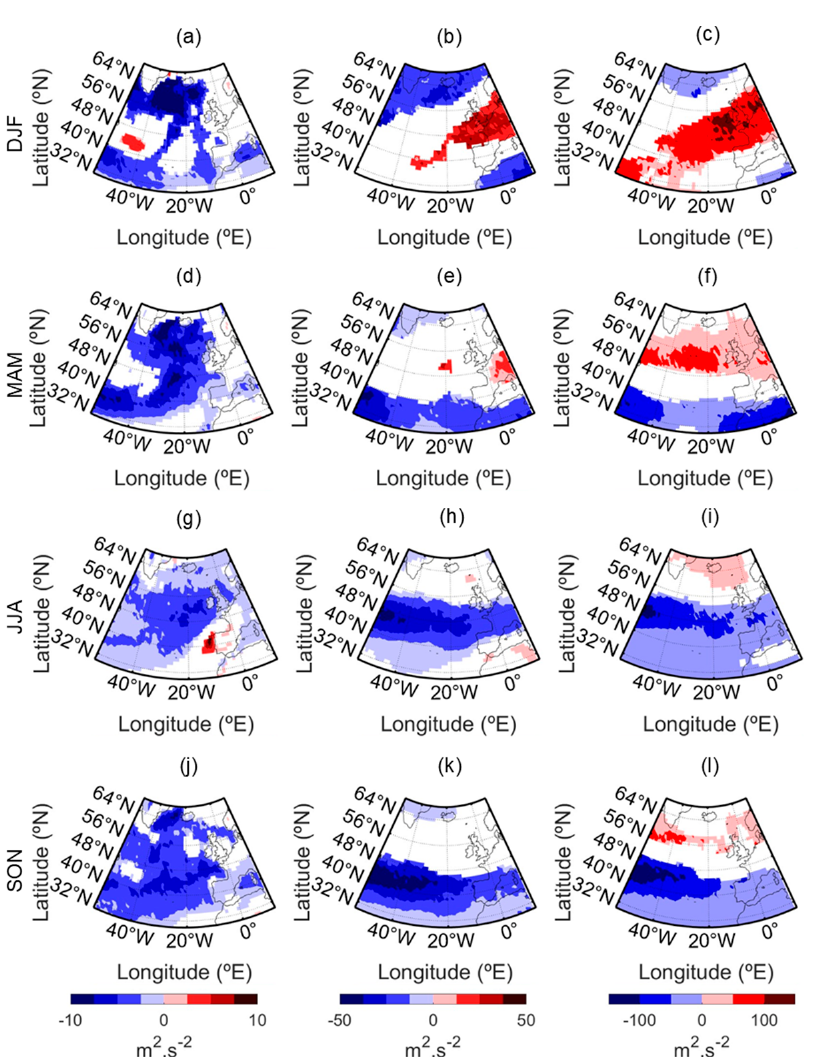
Figure 5. Absolute anomalies of the seasonal (winter: DJF, spring: MAM, summer: JJA, and autumn: SON) median KE (m 2 /s 2 ) for 2081–2100, relative to 1995–2014 (Figure 3), at 10 m (left column ( a , d , g , j )), 500 hPa (middle column ( b , e , h , k )) and 250 hPa (right column ( c , f , i , l )) levels, under SSP5-8.5. In winter, at 500 hPa and 250 hPa, there are negative anomalies over North Africa and the subpolar regions, and major positive anomalies across the mid-latitudes. During spring, the negative anomalies over Africa expand to the entire North Atlantic region equatorward of 40° N, whereas the subpolar anomalies now emerge only over Greenland at the 500 hPa level. As for the positive anomalies, they are smaller than in winter, but still cover much of the mid-latitudes at 250 hPa, within the latitude belt 40–64° N. In summer, at 500 hPa, the major negative anomalies occur between 40° N and 56° N over the Atlantic Ocean and into France, the IP and the British Isles. At 250 hPa, however, while the major anomalies also occur between 40° N and 56° N, the negative anomalies extend further south, reaching North Africa, and are higher than the 500 hPa anomalies.